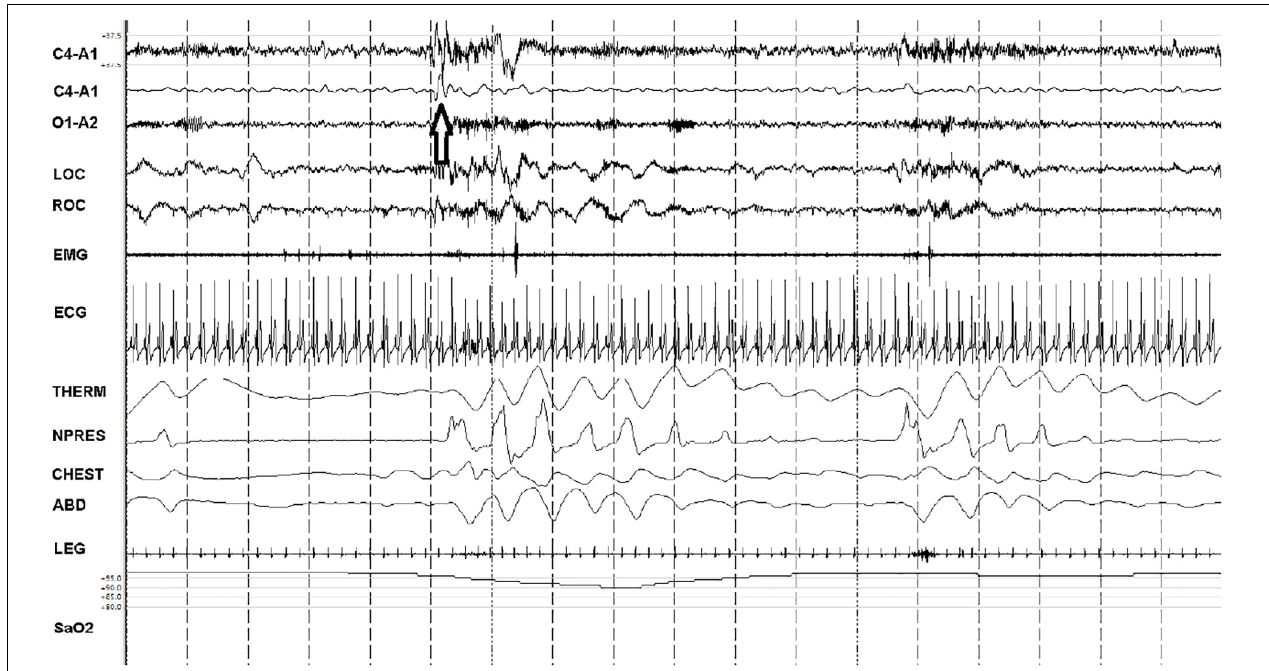
FIGURE 3 | Fragmented slow oscillation and sparse down states. A 90-s snapshot showing sleep state features of ineffective NREM (NREM IE ), stage N2. Note paucity of the < 1 Hz slow oscillation/down states (the arrow identifies an isolated down state, a K-complex) within the 5-s vertical time stamps. The second trace (from above) is a duplicate C4-A1 with filters adjusted to remove frequencies < 1 Hz. This is a sample from a patient with untreated sleep apnea, showing the key characteristics of NREM IE : a fragmented and sparse slow oscillation, cortical arousals, cyclic variation in heart rate and low frequency modulation of HRV and ECG-amplitude that drives detection of this state as “low frequency coupling.” THERM: thermistor airflow. NPRESS: nasal pressure. C4, O1: central and occipital standard EEG sites. A: auricle/mastoid reference. EMG: chin electromyogram. LOC/ROC: left and right outer canthus. LEG: combined right and left tibialis anterior electromyogram. SaO 2 : oxygen saturation via finger probe. ECG: